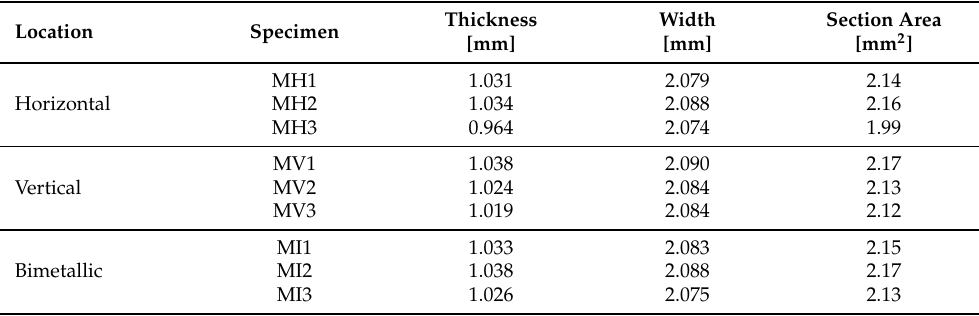
Table 3. Specimen dimensions, measured at the gauge length. Three measurements were conducted along gauge length, with presented value being an average of the three values. Section area computed with average thickness and width values.